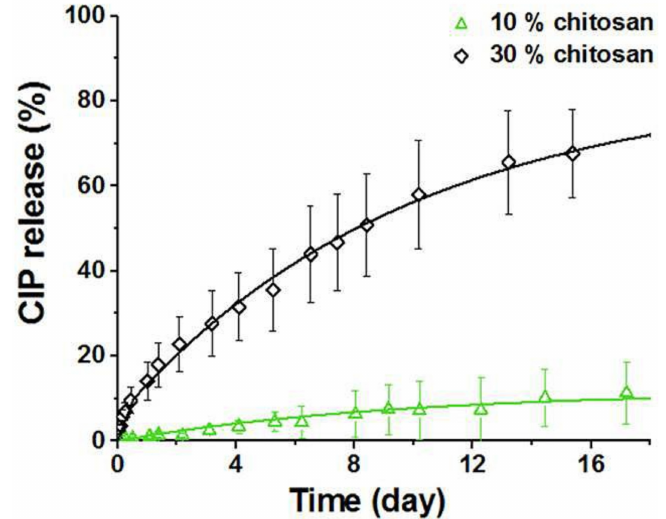
Figure 20. Release profiles of ciprofloxacin (CIP) from blended PMMA nanofibers incorporating different chitosan percentages showing no burst release. Solid lines are best fit (R 2 = 0.99)